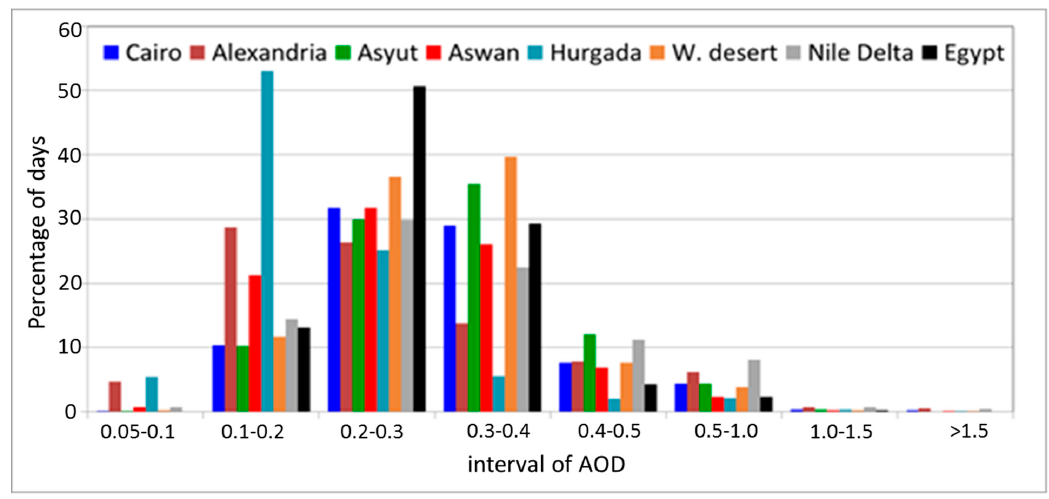
Figure 13. Percentage of the number of days when the AOD falls within the shown intervals within the 12-year study period. Data are from the five selected cities, the two regions, and the entire country. The interannual variability of ADO over Egypt and the selected areas is presented in Figure 14. Except for Cairo and Asyut, no trend can be identified. Cairo and Asyut show a trend of increasing AOD at a rate of 0.0032 and 0.0035 per year (R 2 of 0.743 and 0.688), respectively. The ND region has the highest AOD in all years, but that was matched by the AOD over Asyut after 2010. The AOD over Hurghada is remarkably small. The greatest interannual variability is noticed in the data of Alexandria, Aswan, and the ND region.